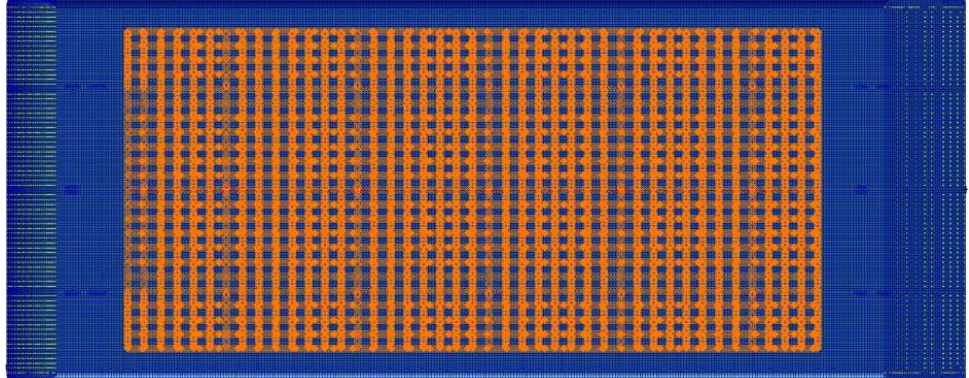
Figure 8. Model boundary conditions.